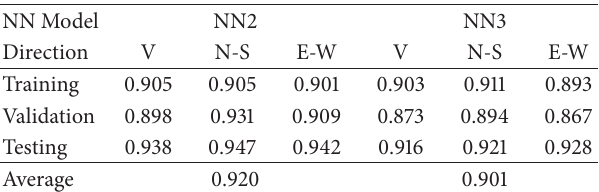
Table 3: Comparison of NN models in different computation stages ( 𝑅 2